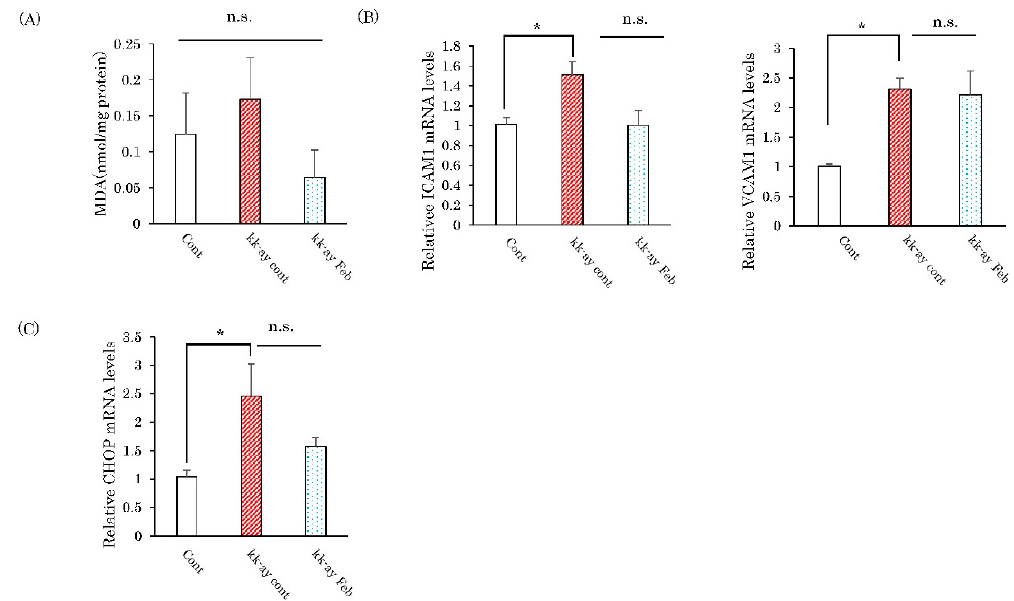
Figure 5. Febuxostat had no significant effect on either oxidative stress or endoplasmic reticulum stress. ( A ) Amounts of malondialdehyde were measured in renal tissues. ( B ) Relative mRNA levels of ICAM-1 and VCAM-1 in the kidneys. ( C ) Relative mRNA levels of CHOP in the kidney. Data are means ± SE. * p < 0.05, n = 8 in control group and KK-Ay mice with febuxostat, n = 10 in KK-Ay mice without febuxostat